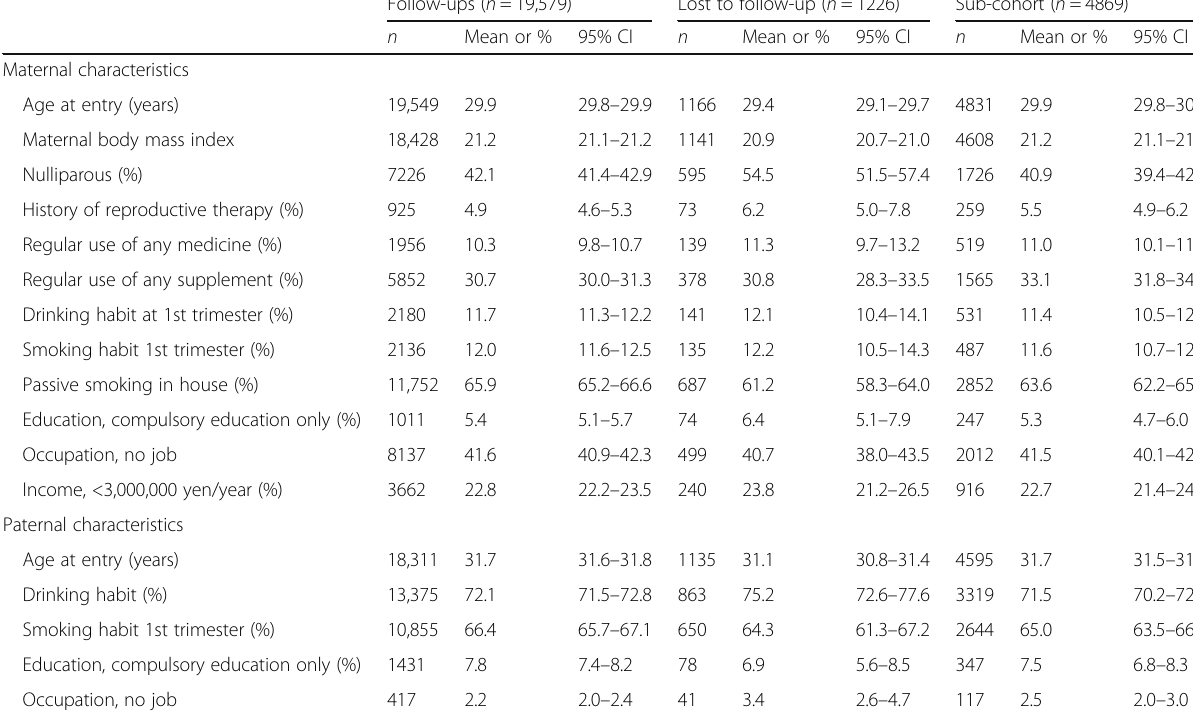
Table 4 Comparison of the characteristics of the Hokkaido cohort participants included and lost to follow-up Follow-ups ( n = 19,579) Lost to follow-up ( n =